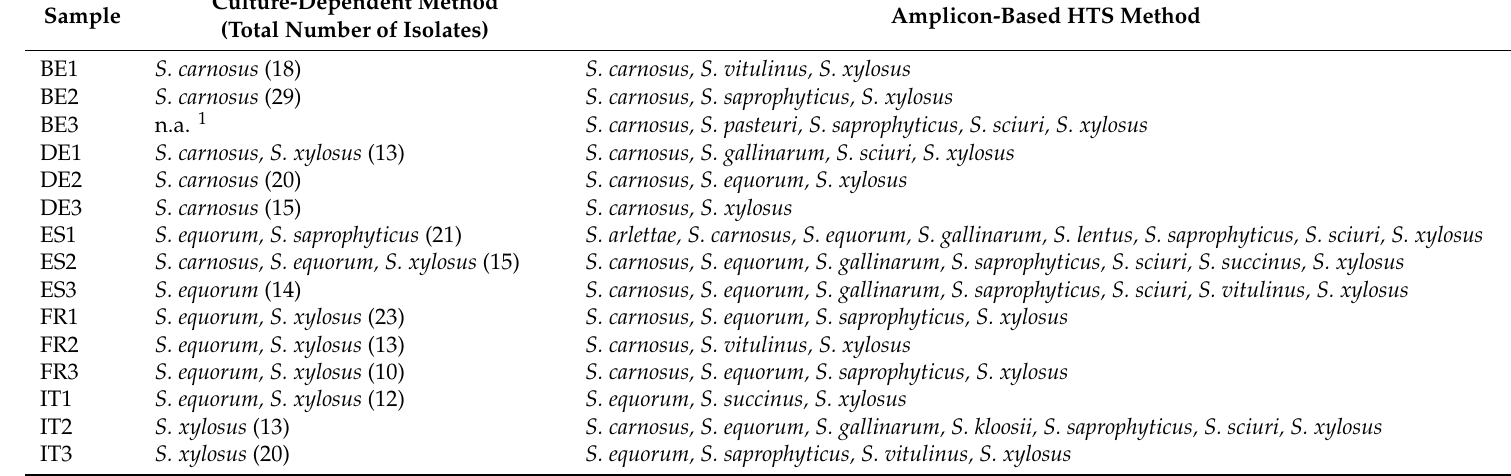
Table 3. Comparison of the Staphylococcus ( S.) species diversity in selected commercial fermented meat products obtained using culture-dependent methods (data obtained from Van Reckem et al., 2019) versus the use of the amplicon-based high-throughput sequencing (HTS) method targeting the tuf gene (present study). Fermented meat products originated from BE (Belgium), DE (Germany), ES (Spain), FR (France), and IT